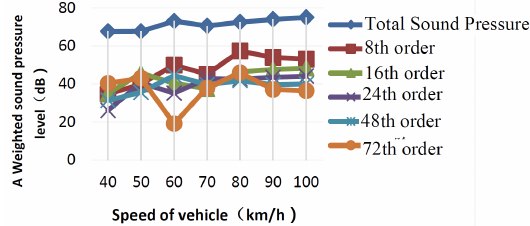
Fig. 4. Noise order analysis on the left side of Road (Constant driving speed condition).